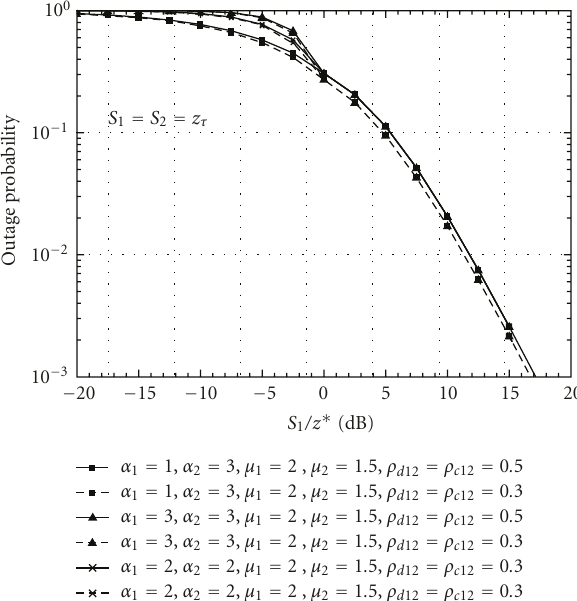
Figure 1: Outage probability ( P out ) versus normalized outage threshold for the balanced dual-branch SSC diversity receiver and di ff erent values of ρ 12 d , ρ 12 c , μ 1 , μ 2 , α 1 and α 2 .